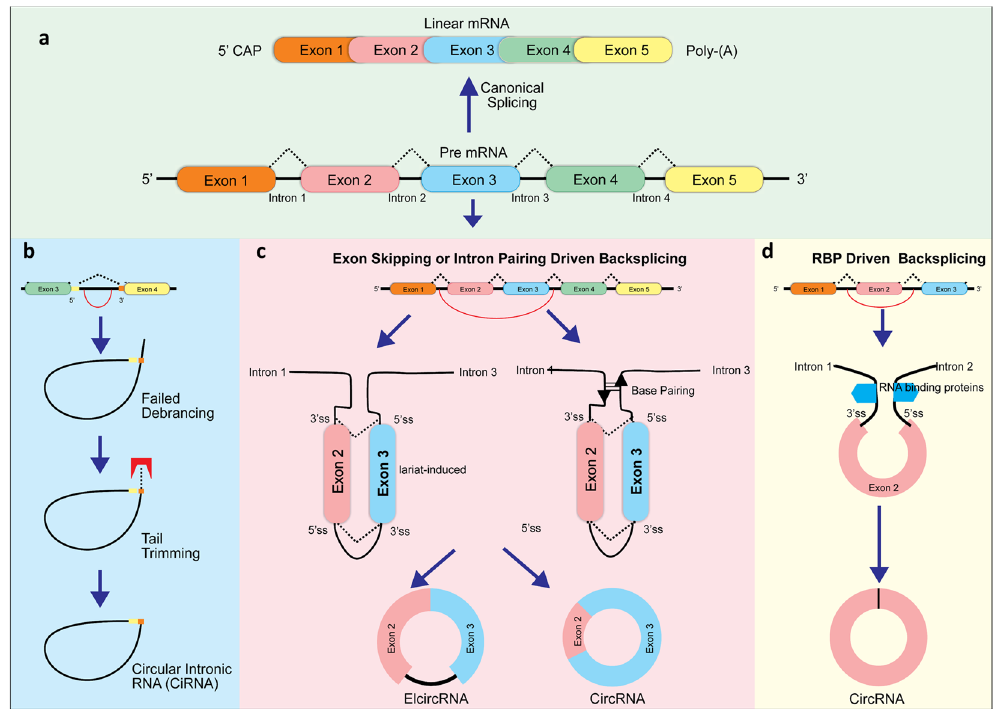
Figure 1. CircRNA biogenesis. The classic splicing typically generates linear RNA. However, this splicing can also produce circular intronic RNAs (ciRNAs) from intronic lariat precursors ( a ) when avoiding debranching via the presence of consensus RNA sequences (yellow) ( b ). In addition, long flanking introns, inverted repeat elements, and RNA binding proteins (RBP) boost backsplicing, including exon skipping ( c ), intron pairing driven ( c ), and RBP-driven backsplicing ( d ).